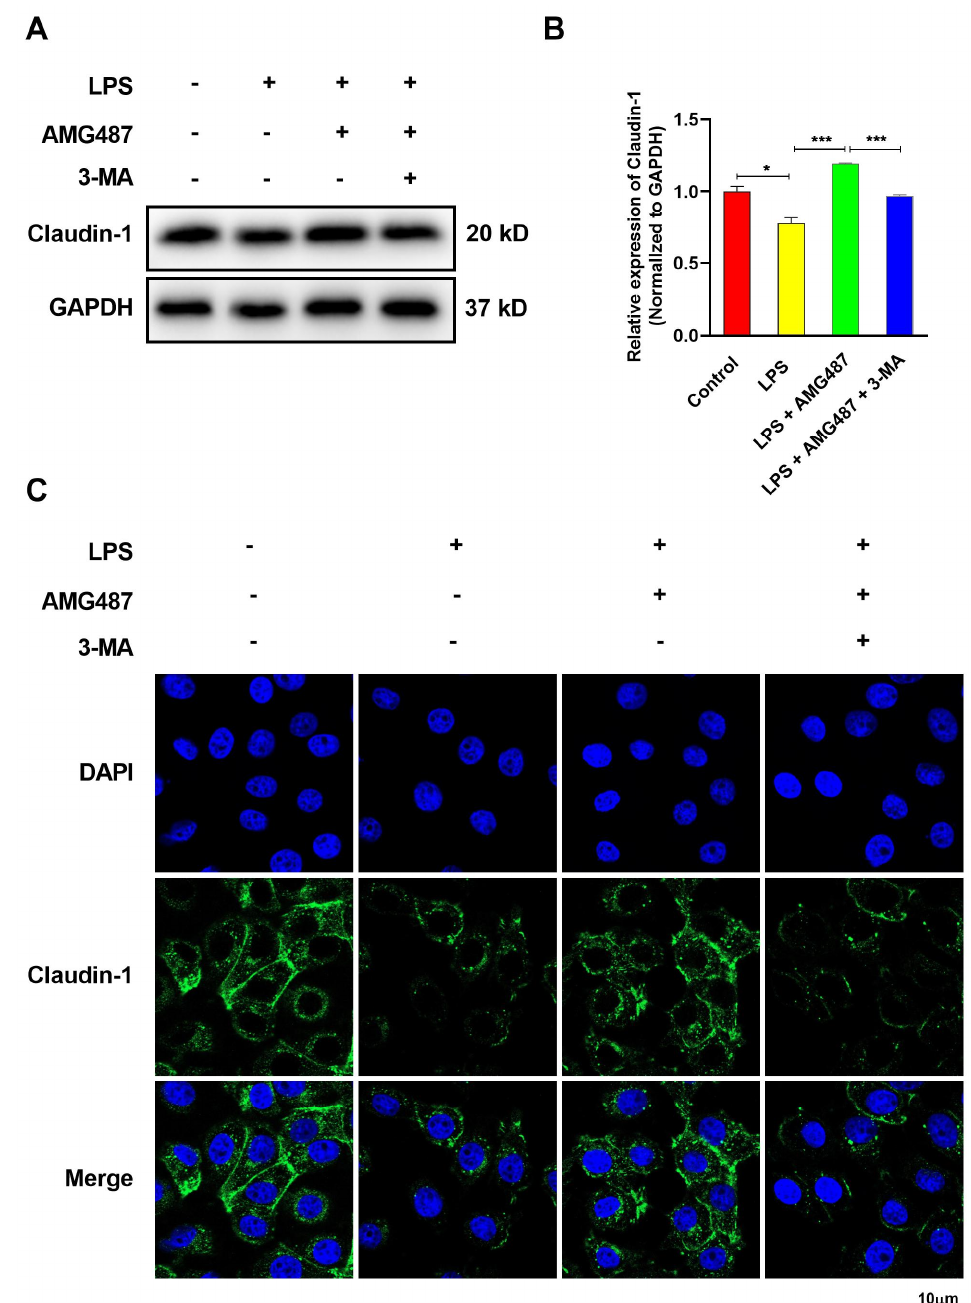
Figure 7. CXCR3 inhibition promotes tight junction protein expression by elevating autophagy in the IPEC-J2 cells. The cells were divided into four groups, namely, the Control group, LPS (10 µ g/mL) group, LPS + AMG487 (1 µ M) group, and LPS + AMG487 + 3-MA (5 mM) group. The cells were treated for 12 h, and the protein was extracted for Western Blot. Indirect immunofluorescence assays were explored. ( A ) Claudin-1 protein expression. ( B ) Image J software analysis of Claudin-1 protein optical density values. ( C ) Indirect immunofluorescence confocal imaging of the distribution of the Claudin-1 protein. Values represent the mean ± SEM. of three independent experiments. Significant differences are represented by * p < 0.05, *** p < 0.001, and ns (not